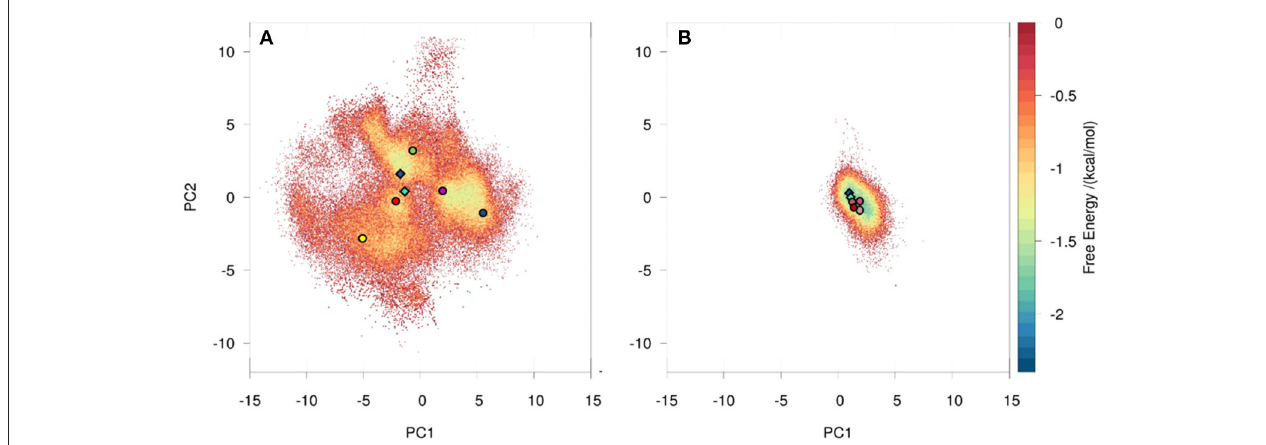
FIGURE 1 | Conformational space of the naïve (A) and the matured (B) 7G12 antibody with the projection of the crystal structures as diamonds (bound state: dark blue, free state: cyan). The variances for the PC1 and PC2 are 45 and 20% respectively. Both 10 µ s trajectories are projected onto the combined PCA space, resulting in one distinct and narrower free energy basin for the matured and a shallow and broad free energy surface for the naïve antibody. Projections of representative structures for each Markov state are depicted as circles color-coded according to the Markov-state model shown in Figure 2 .